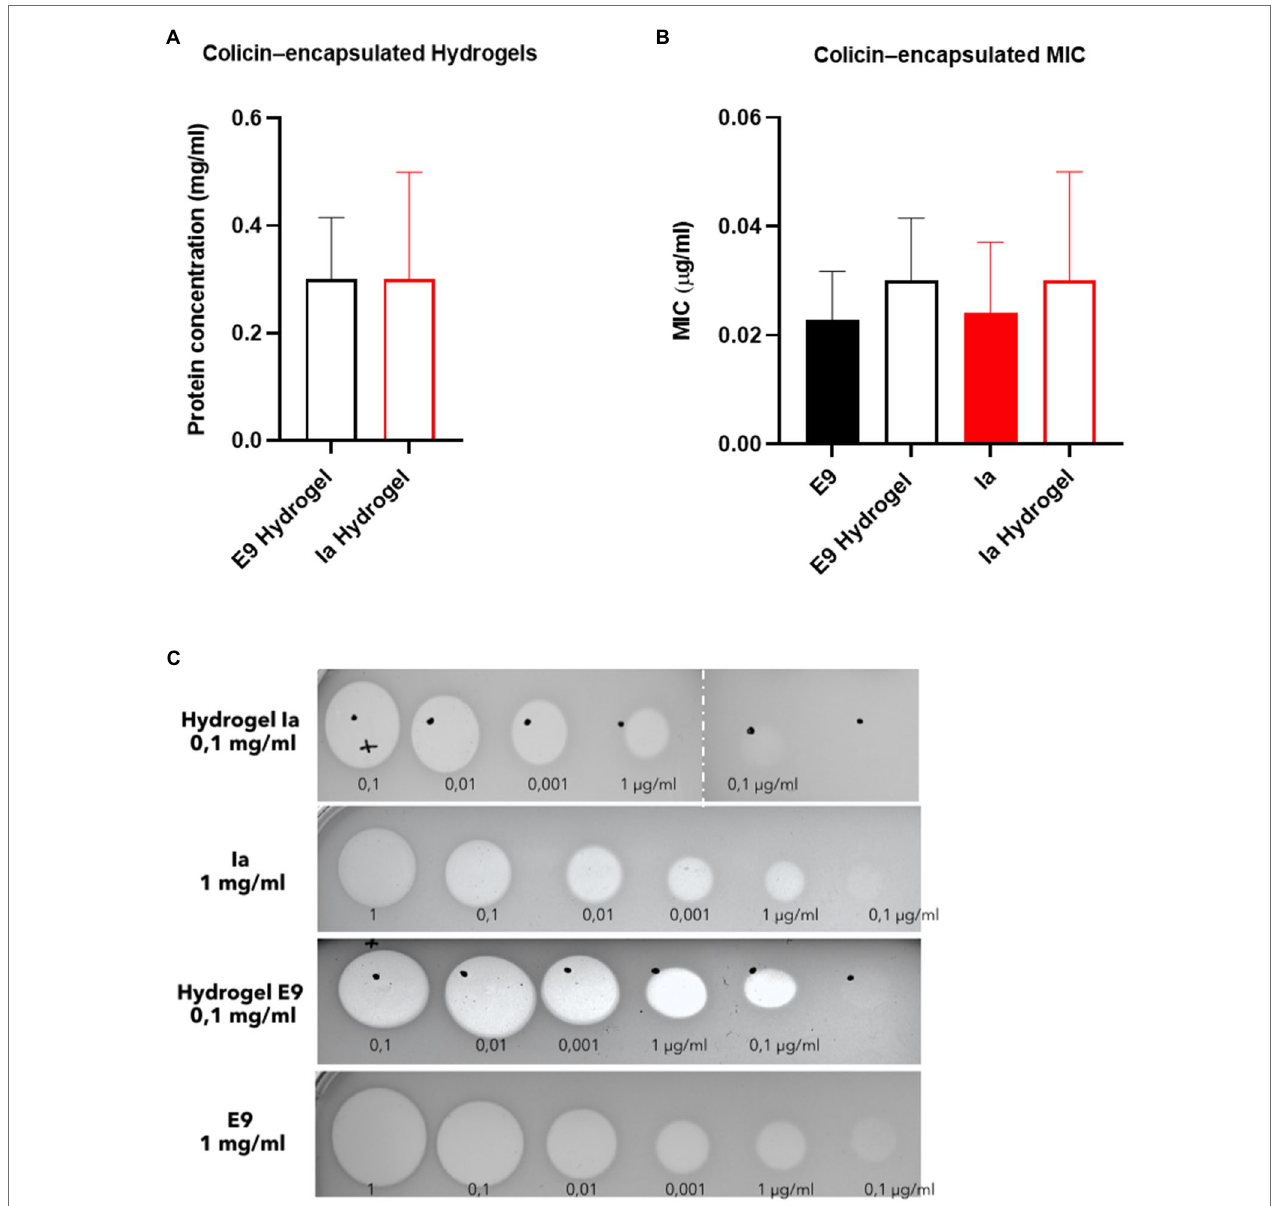
FIGURE 4 | Killing activity of hydrogel-encapsulated colicins. (A) Levels of encapsulated protein (mg/ml) after suspension. (B) Minimum inhibitory concentration (MIC) and (C) inhibition of growth of E. coli LF82StrpR by colicins E9 and Ia and hydrogel-encapsulated colicin E9 and Ia. Clear zones indicate cell death. Data represent four different experiments (mean ± SD). Statistical analysis was carried out for each subset using a Mann–Whitney test between the control protein and the hydrogel particles and no significant differences were found. Hydrogel microcapsules that did not contain encapsulated colicins showed no bactericidal